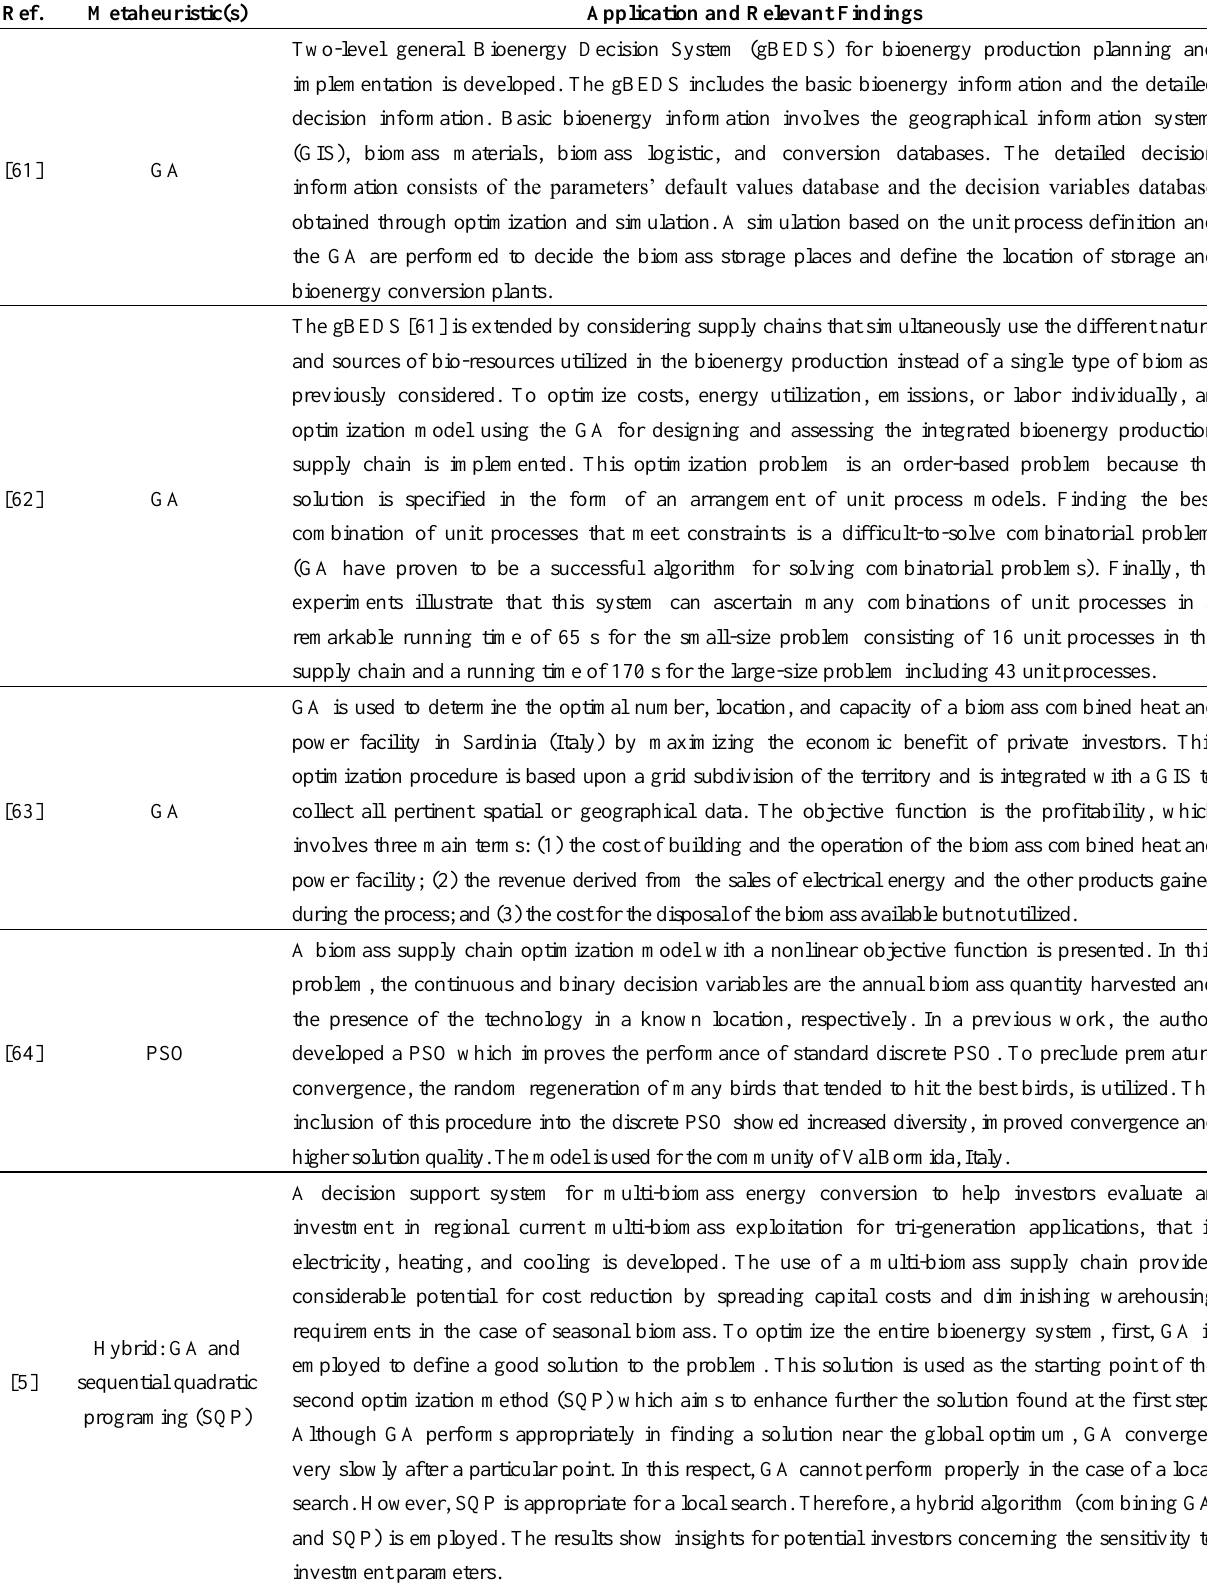
Table 6. Reviewed articles in the integrated supply chain planning